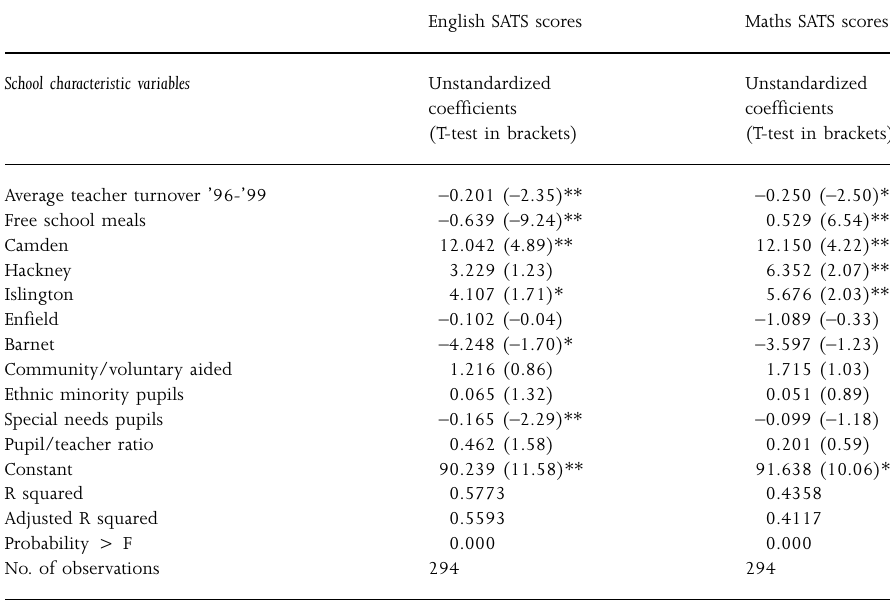
Table 3 The effect of school characteristics on SATS scores English SATS